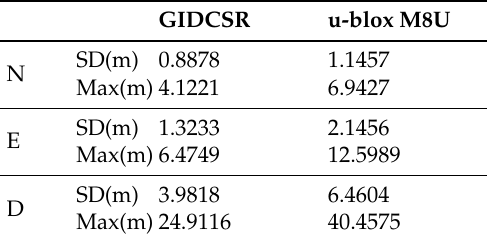
Table 5. Statistics of GNSS positioning errors.